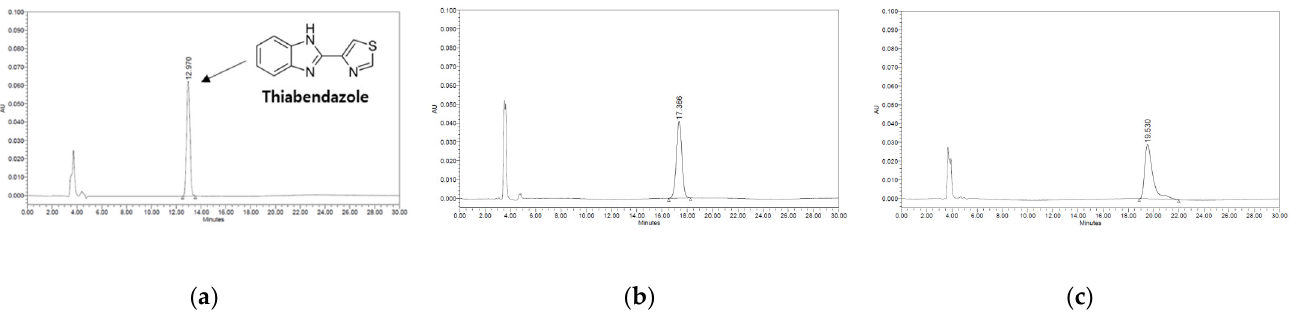
Figure 1. Change in high-performance liquid chromatography (HPLC) chromatograms of thiabendazole using different C18 columns. ( a ) Shiseido column. ( b ) Waters column. ( c ) Phenomenex column.